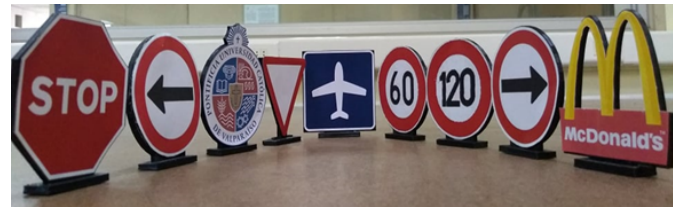
Figure 1. Traffic signals that must be detected.